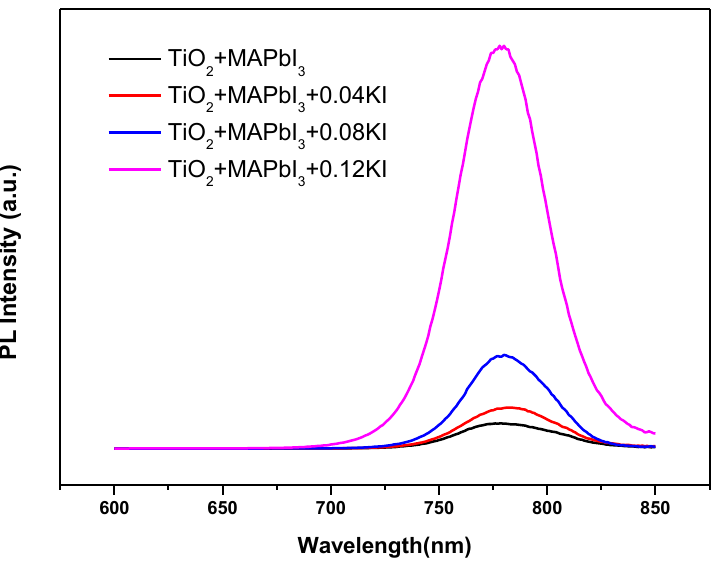
Figure 6. PL spectra of perovskite layer with different K + concentrations.